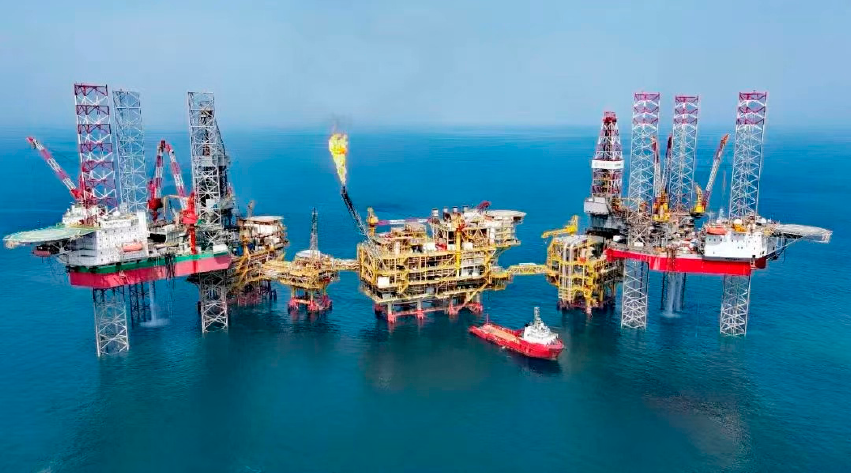
Figure 1. Weizhou Oilfield.